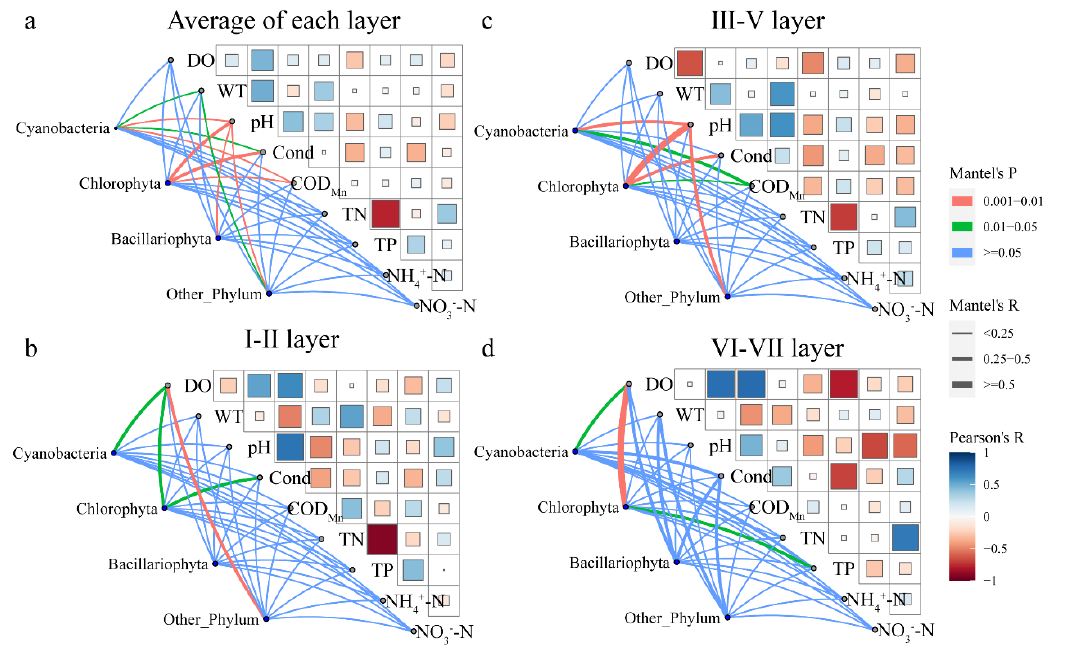
Figure 7. Physicochemical variables and abundance of phytoplankton phyla composition in the Danjiangkou Reservoir. (( a ) Average of each layer; ( b ) Ⅰ – Ⅱ layer; ( c ) Ⅲ – Ⅴ layer; ( d ) Ⅵ – Ⅶ layer). Pearson correlation analysis was performed between the abundance of the dominant phytoplankton species and the physicochemical factors in the whole Danjiangkou Reservoir (Figure 8a). In addition, Chlamydomonas sp. (r = 0.131, p = 0.010), Cymbella sp. (r = 0.115, p = 0.024) and Cryptomonas erosa (r = 0.147, p = 0.004) (Chlorophyta, Bacillariophyta, and Cryptophyta, respectively) were positively correlated with the DO concentration. The abundance of Stigeoclonium sp. (r = − 0.131, p = 0.010) and Radiococcus nimbatus (De Wildeman) Schmidle (r = − 0.122, p = 0.016) were negatively correlated with the DO concentration. Three algal species from Cyanobacteria, eight algal species from Chlorophyta, two algal species from Bacillariophyta, and three algal species from other phyla accounted for a total of sixteen algal species, and their abundance was significantly positively correlated with WT. The abundance of four species of Chlorophyta, three species of Bacillariophyta, and one species of Cryptophyta was significantly positively correlated with pH. The abundance of three algal species in Cyanobacteria, three algal species in Chlorophyta, one algal species in Bacillariophyta, and two algal species in other phyla was significantly positively correlated with COD Mn . A total of eight algal species, including one species from Cyanobacteria, four species from Chlorophyta, two species from Bacillariophyta, and one species from Cryptophyta, were found to be significantly positively correlated with the NH 4+ -N con- centrations. The abundance of Chlamydomonas sp. (r = − 0.184, p < 0.001) and Cryptomonas erosa (r = − 0.114, p = 0.026) were negatively correlated with Cond, while the abundance of the Dinobryon sp. (r = 0.107, p = 0.036) of Ochrophyta was positively correlated with Cond. The abundance of Planctonema lauterbornii , Stigeoclonium sp., and Chlamydomonas sp. were significantly positively correlated with the TN and NO 3 − -N concentrations. The abundance of Scenedesmus capitato-aculeatus C.-C.Jao & Z.-Y.Hu (r = − 0.102, p = 0.045) was negatively correlated with the TN concentration, while that of Cryptomonas erosa (r = 0.151, p = 0.003) was positively correlated with the TN concentration. The abundance of Scenedesmus bijugus , Aulacoseira granulate , and Cymbella sp. was negatively correlated with the NO 3 − -N concentration, while that of Cryptomonas erosa was positively correlated with the NO 3 − -N concentration. The abundance of Anabaena sp. (r = 0.204, p < 0.001) of Cyanobacteria was significantly positively correlated with the TP concentration.